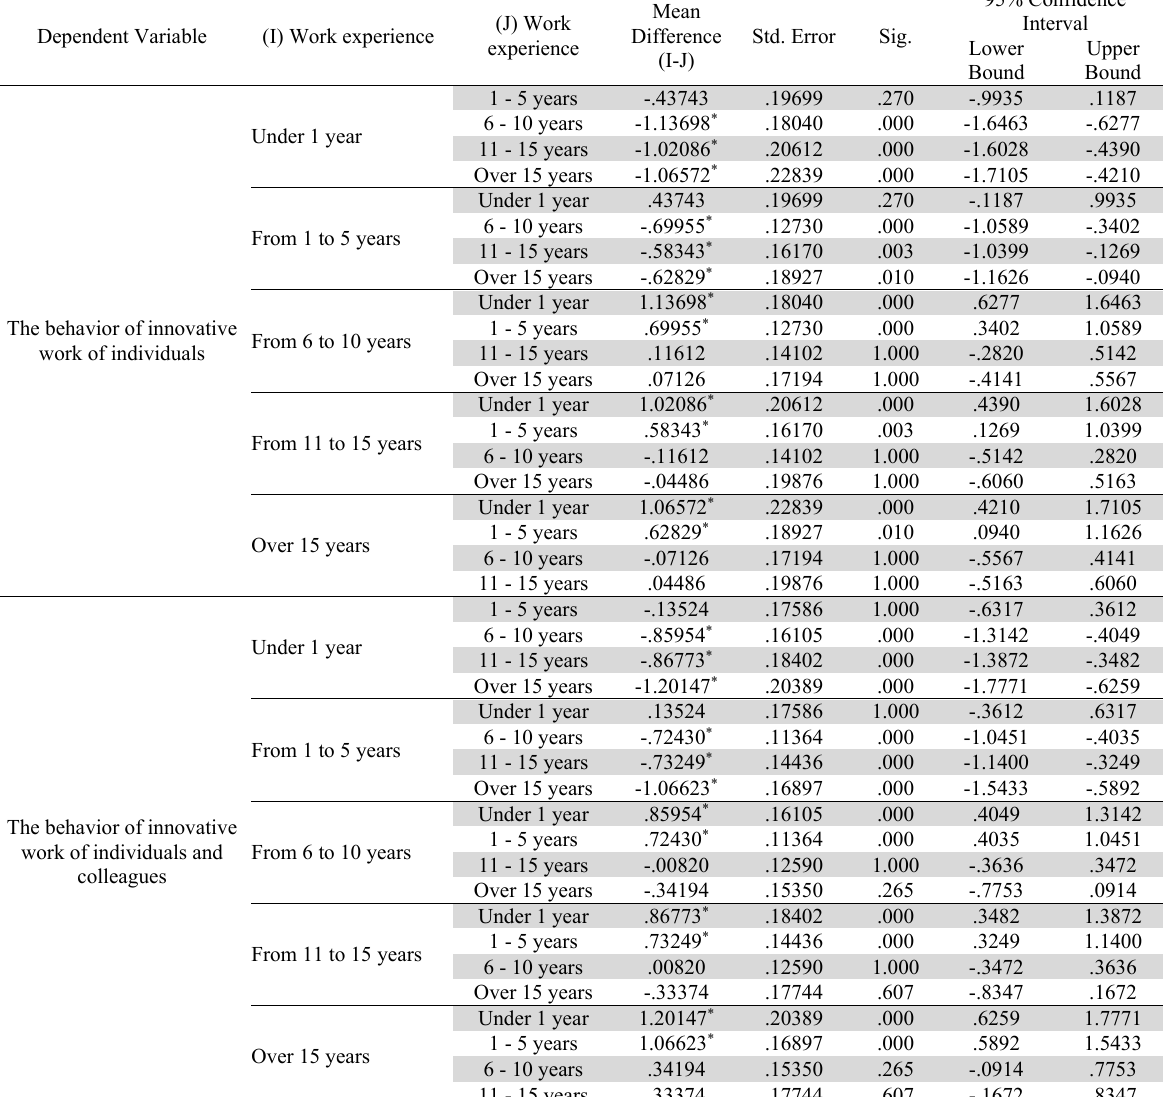
Analyzing differences by work experience when evaluating IWB Dependent Variable (I) Work experience